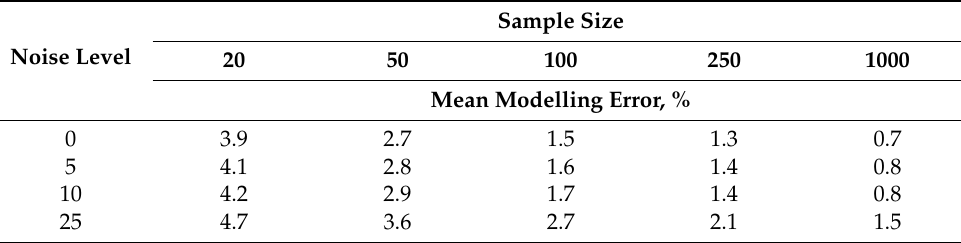
Table 5. Results of the study of nonparametric models by adjusting smoothing factors by a hybrid GA with local search on a test